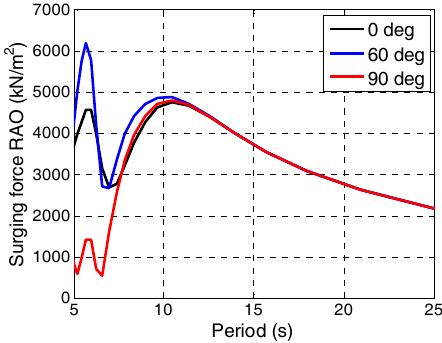
Figure 13. Comparisons of surging force RAOs between three wave directions.